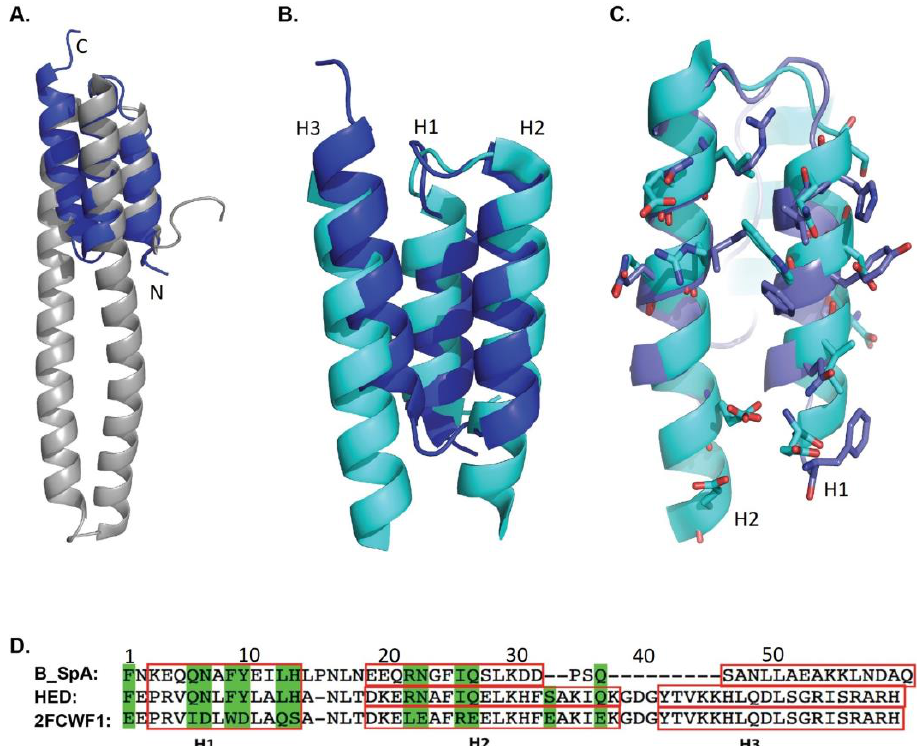
Figure 1. Design of HED domain. ( A ) Three-dimensional structural alignment of a human Alpha-2-macroglobulin receptor-associated protein (Alpha-2-MRAP, Chain A of PDB 2FCW, grey) with the domain D (blue) of Staphylococcus Protein A in the complex crystal structure with the Fab fragment of a human IgM antibody (PDB code: 1DEE). ( B ) The corresponding region of Alpha-2-MRAP to the D-domain of SpA (2FCWF1) was selected for modeling and colored in cyan. ( C ) The original model of 2FCWF1 was superimposed on the structure of the B-domain of SpA from its complex with the Fc fragment of human IgG1 (PDB code: 1FC2). The interface residues of the B-domain and the Fc fragment and the corresponding residues in the model of 2FCWF1 are shown as sticks on their cartoon model, and their carbon atoms are painted in blue and cyan, respectively. ( D ) The primary sequence alignment of 2FCWF1, B-domain of SpA, and HED domain. The residues mutated from Alpha-2-MRAP to the B-domain of SpA are shown in green shadow, and the helixes of their secondary structure and the predicted helixes of HED are labeled as H1, H2, and H3 and highlighted with red